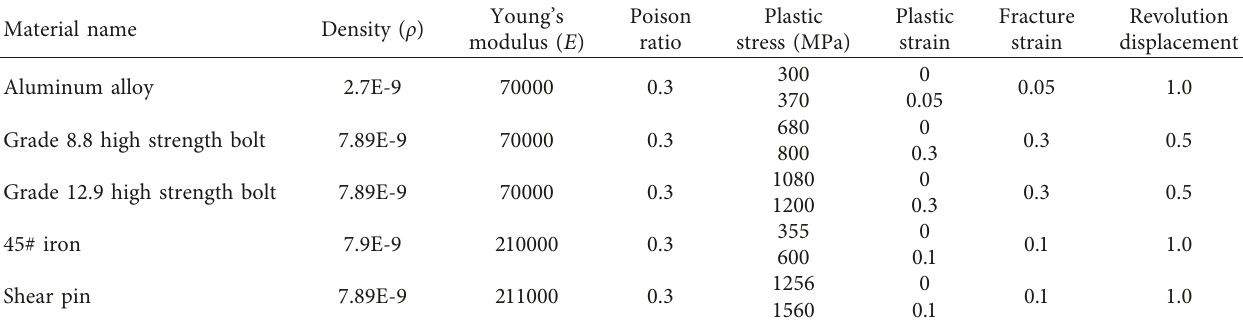
Table 2: The material parameters in the FEM.